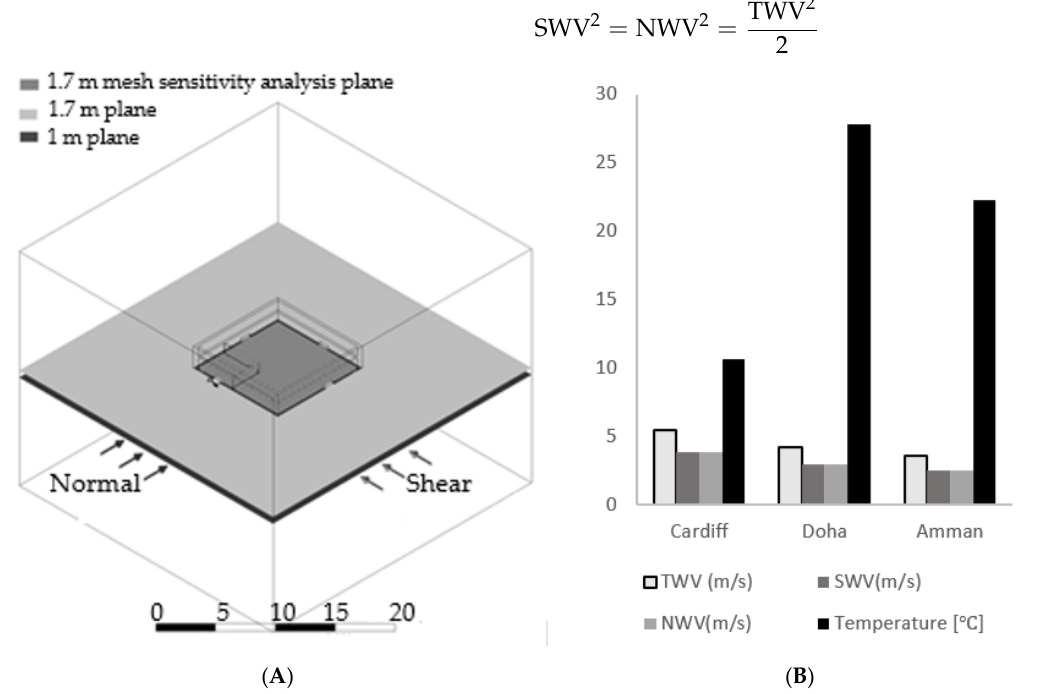
Figure 5. ( A ) Internal and external computational domains—two planes at 1 m and two planes at 1.7 m; ( B ) computational setups of temperature and wind